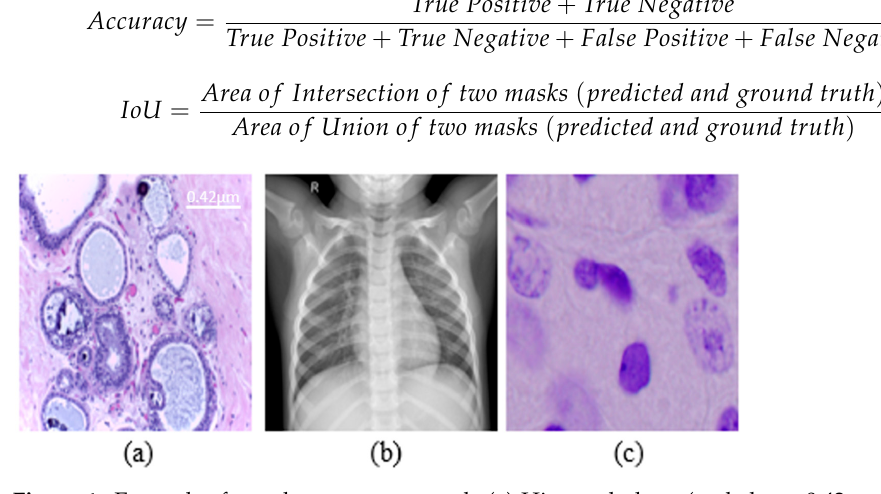
Table 3. Image quality and accuracy in chest X-ray images under attacks (in %).